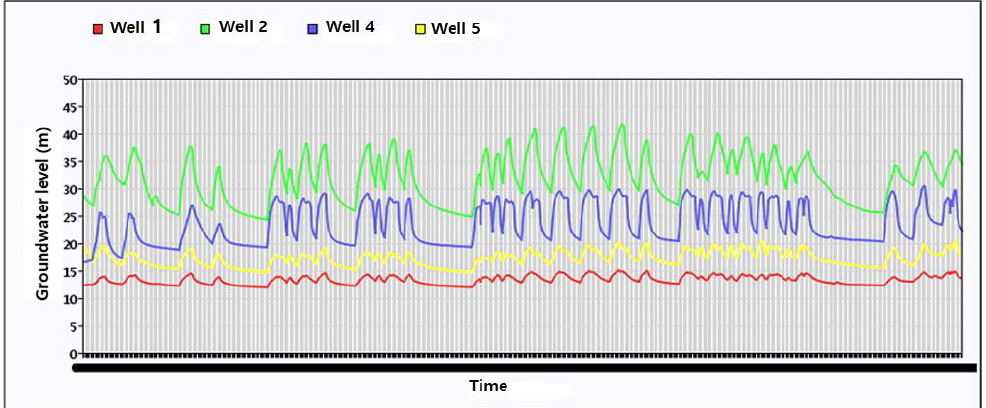
Figure 3. Mineral water level data (monitoring well 1 of red color, monitoring well 2 of green color, monitoring well 4 of violet color, and monitoring well 5 of yellow color) are transmitted from the mineral water manufacturers based on real-time. Horizontal axis is the measurement time and vertical axis is the water level value. Numbers represent depth to water (unit: m).